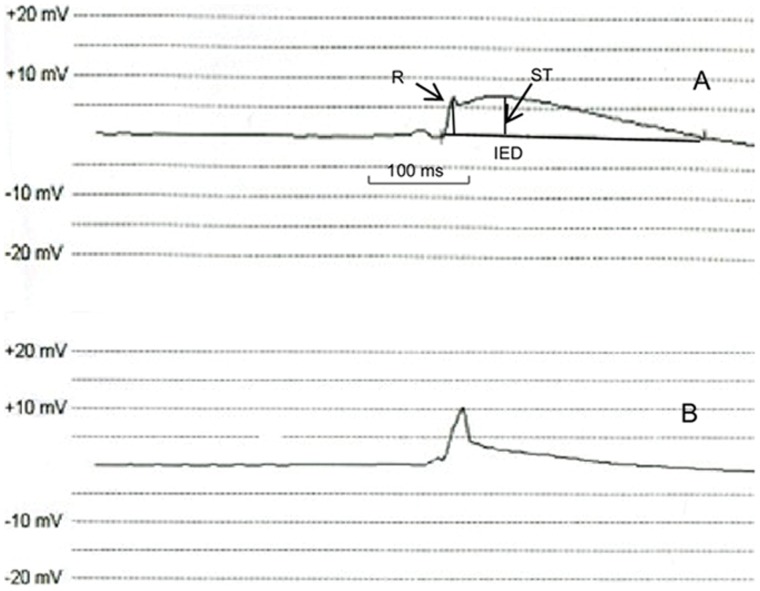
Example of intracardiac electrogram recorded by pacing system analyzer (200
mm/s). A. Onset of COI, manifested as ST-segment elevation after R wave deflection and increase of intracardiac electrogram duration (IED). B. Resolution of COI, ST-segment declined to less than 1/4 of R wave amplitude, and the significant decrease in IED also occurred.